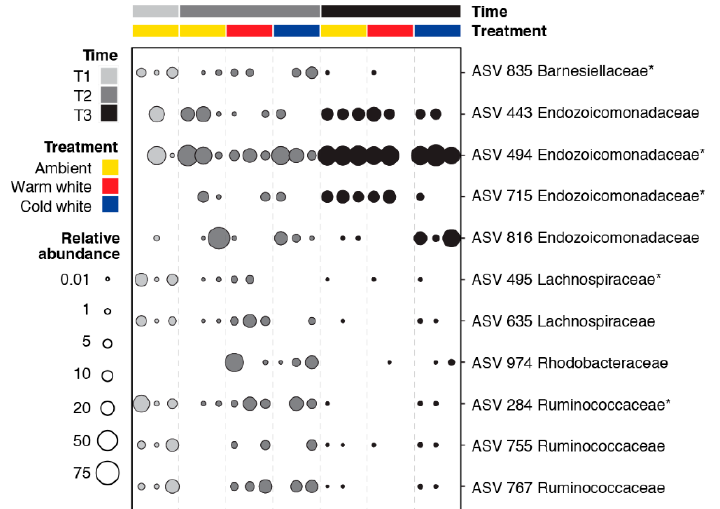
Figure 3. Bubble plot showing the relative abundance of 11 differentially abundant ASVs in corals exposed to different light treatments and collected at different timepoints (T1, January; T2, February; and T3, March). Differentially abundant ASVs were identified using ALDEx2 with an effect size greater than |3|. ASVs with asterisks were also identified as bacterial indicator taxa using the indicspecies package (Figure S3).